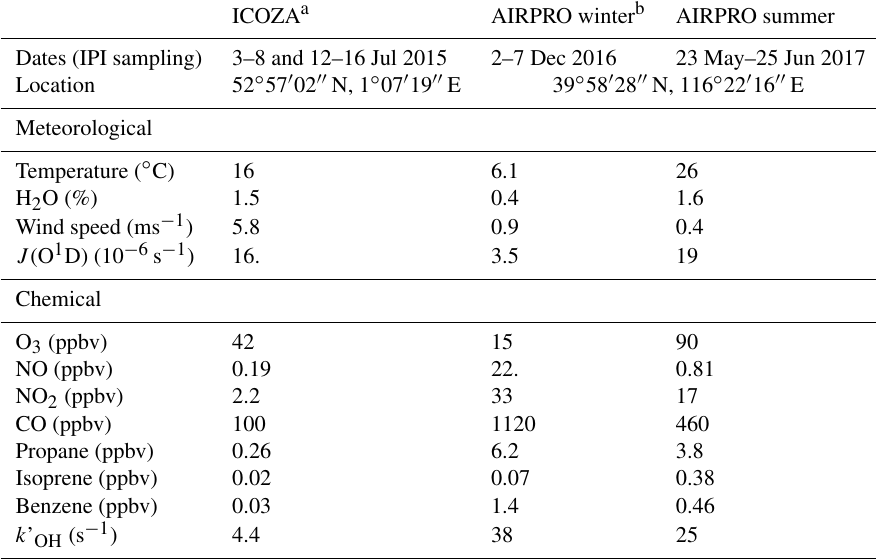
Table 1. Overall meteorological and chemical conditions encountered during each field campaign, including example VOCs. Values are given as the median of all points that coincide with IPI sampling periods, except for J (O 1 D) and O 3 , which are reported as diurnally averaged